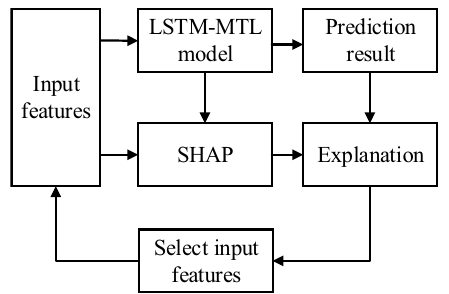
Fig. 2 Overview of how to use SHAP to interpret the predictions of the LSTM-MTL